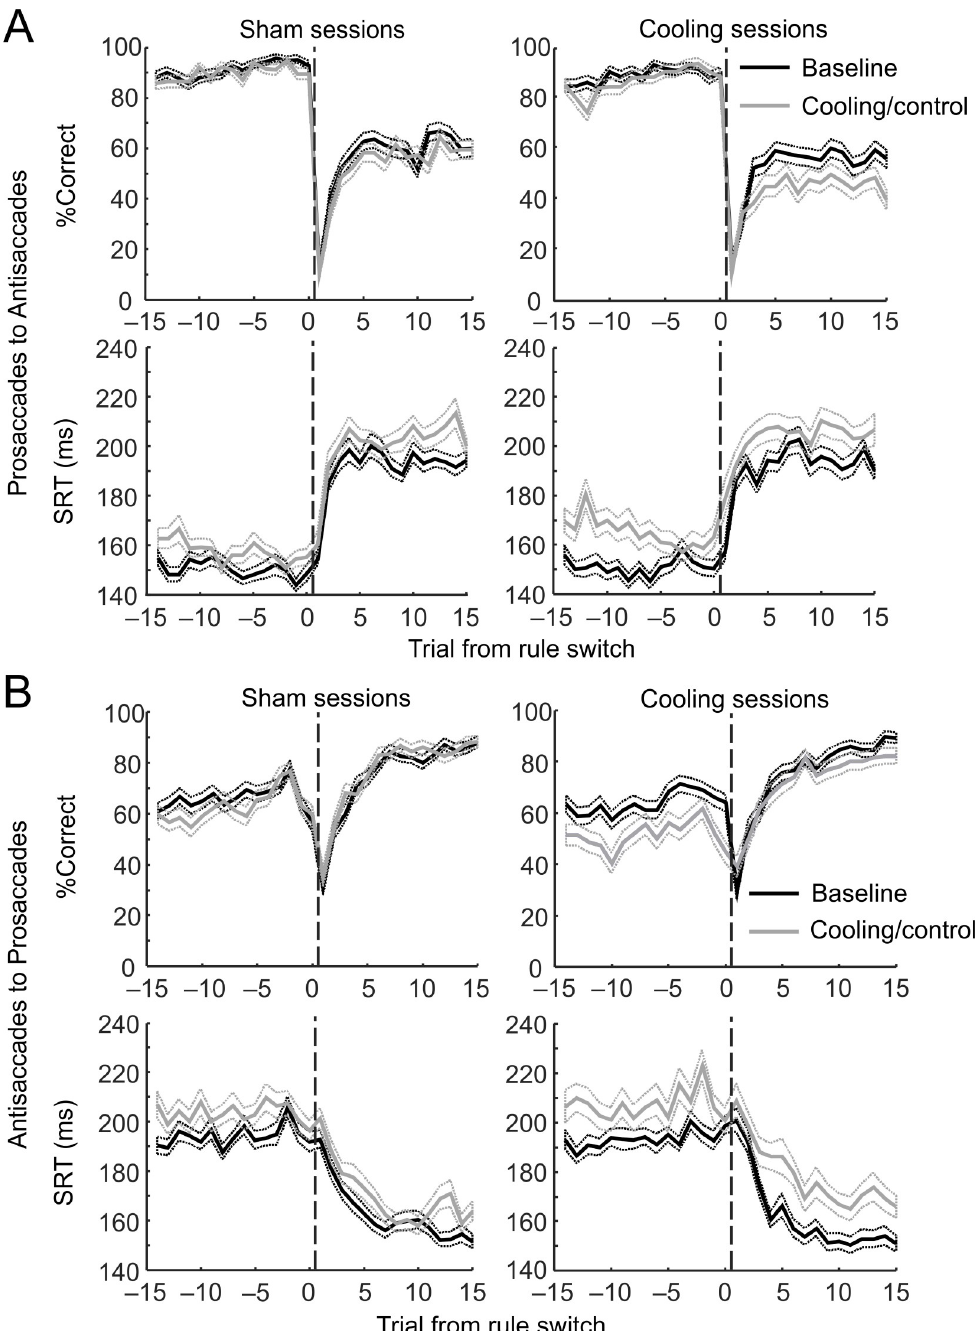
Fig 2. dACC deactivation impaired behavioral performance in antisaccade trials and increased the SRTs under both rules. See S1 Table and S2 Table for complete lists of test statistics, p -values, effect sizes, and statistical power. (A) Switches from the prosaccade to the antisaccade rule. Top panels: in both sham (left) and cooling (right) sessions, percentages of correct trials—averaged across all trial blocks completed—dropped sharply at the first trial after the rule switches but rose quickly (the Early stage) to a plateau at approximately the fifth trial post switch. In sham sessions (top left panel), the performance remained unchanged from the baseline (black curve) to the control epoch (gray curve) on either the pre- switch prosaccade trials (to the left of the dashed line) or the post-switch antisaccade trials (to the right of the dashed line). Cooling impaired the animals’ performance in the post-switch antisaccade trials (top right panel, gray versus black curves, to the right of the dashed line) but not in the pre-switch prosaccade trials (to the left of the dashed line). Bottom panels: cooling significantly increased the SRTs of correct responses in both the pre-switch prosaccade responses and the